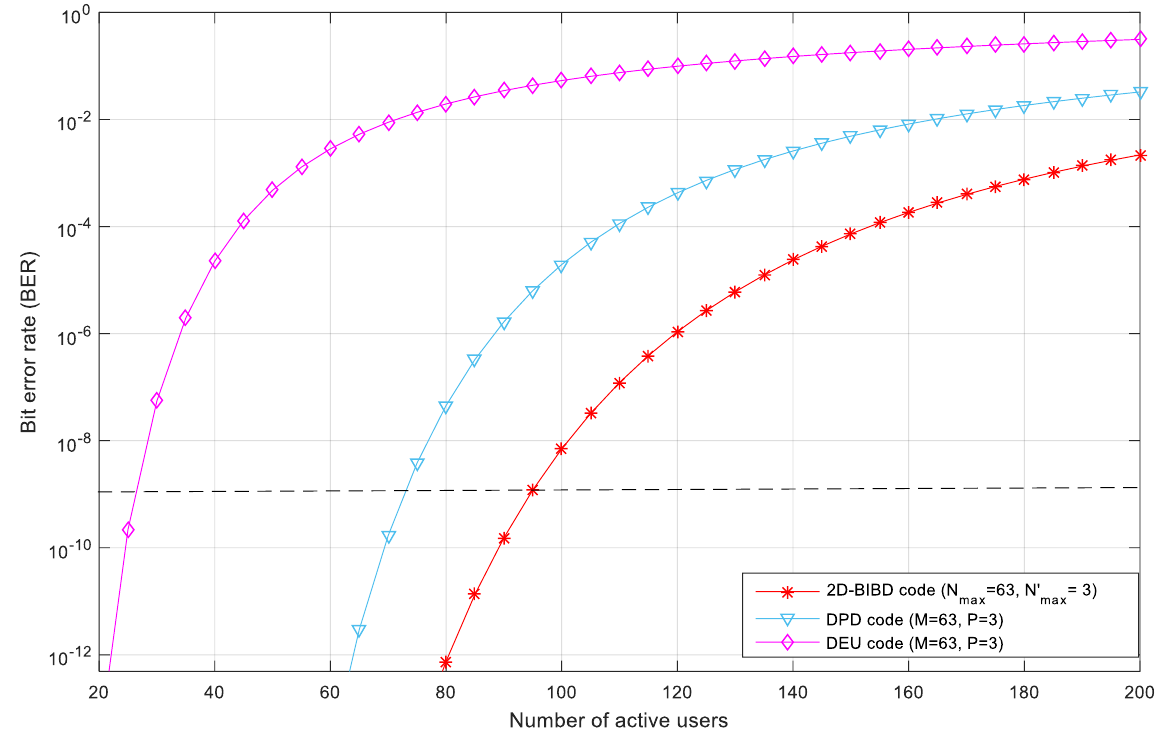
Appl. Sci. 2021 , 11 , x FOR PEER REVIEW Figure 3. Dependence of BER on the maximum number of simultaneous users ( K ) at input transmitted power ( P sr = − 10 dBm) for 2D-BIBD ( N max = 63, N’ max = 3), 2D-DEU code (M = 63, P = 3), and 2D-DPD ( M = 63, P =3).